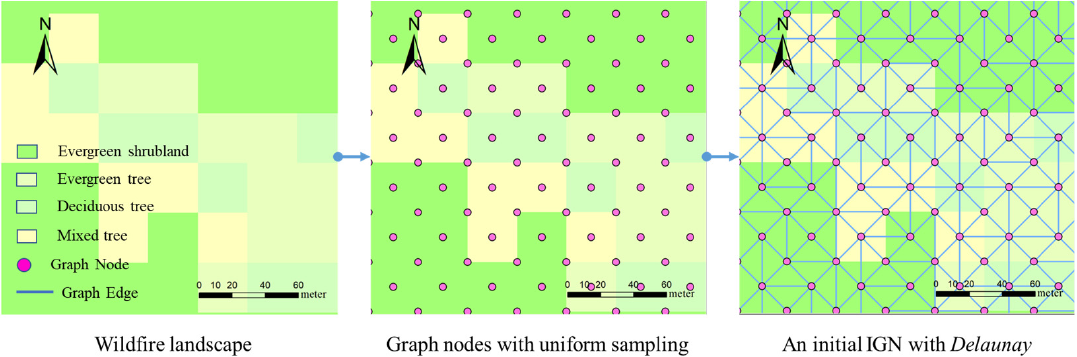
Figure 2. IGN initialization .